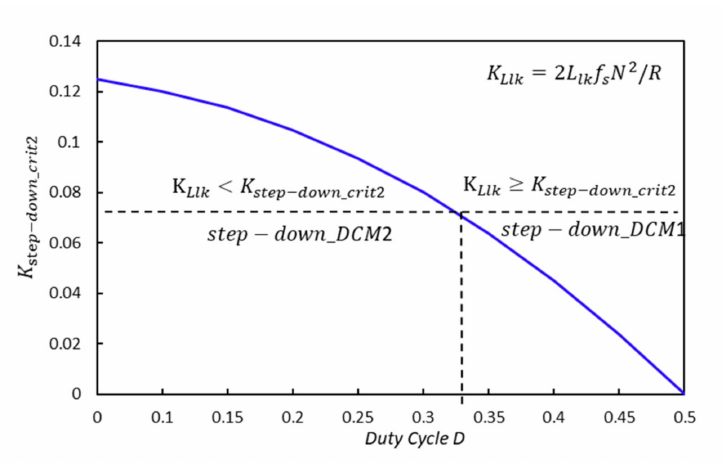
Figure 9. Boundary between step-down-DCM1 mode and step-down-DCM2